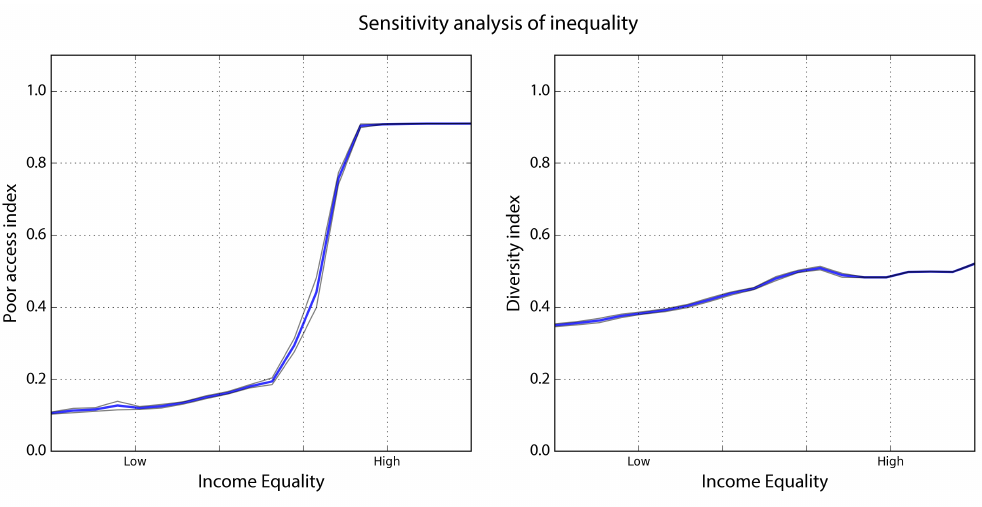
Figure 10. The values for poor access indicator and diversity indicator on which the model converged over 50 runs given different income inequality parameter values, with all other parameters held at their baseline values. The mean value is blue and the gray lines depict the 95% confidence